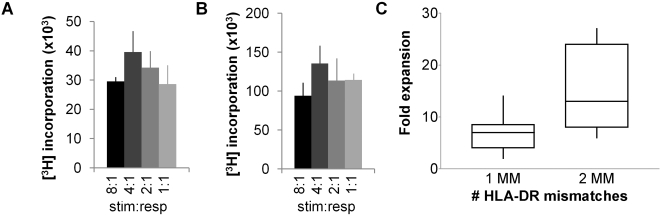
Determination of optimal strength of alloantigen Treg stimulation.(A) Treg were stimulated with indicated ratios of irradiated allogeneic PBMC in the presence of IL-2 and IL-15. Proliferation was determined by measurement of [3H]Thymidine incorporation at day 5. Data are representative of three independent experiments. (B) Treg primed with alloantigen were restimulated with indicated ratios of irradiated allogeneic PBMC in the presence of IL-2 and IL-15. Proliferation was determined by measurement of [3H]Thymidine incorporation at day 3. Data are representative of three independent experiments. (C) Efficiency of primary alloantigen stimulated expansion is related to the number of HLA-DRB1 mismatches. Freshly isolated Treg were expanded in one cycle in the presence of IL-2 and IL-15 and stimulation by gamma irradiated allogeneic PBMC with one (N = 10) or two (N = 6) mismatches on HLA class II DRB1 genes. Expansion values were calculated by relating the number of cells set up in the initial culture to the number of cells after expansion (after two days rest). Expansion was higher with alloantigen mismatched on two HLA-DRB1 genes as compared to alloantigen with one mismatch. This difference was found to be statistically significant in a Mann Whitney test (P = 0.025).